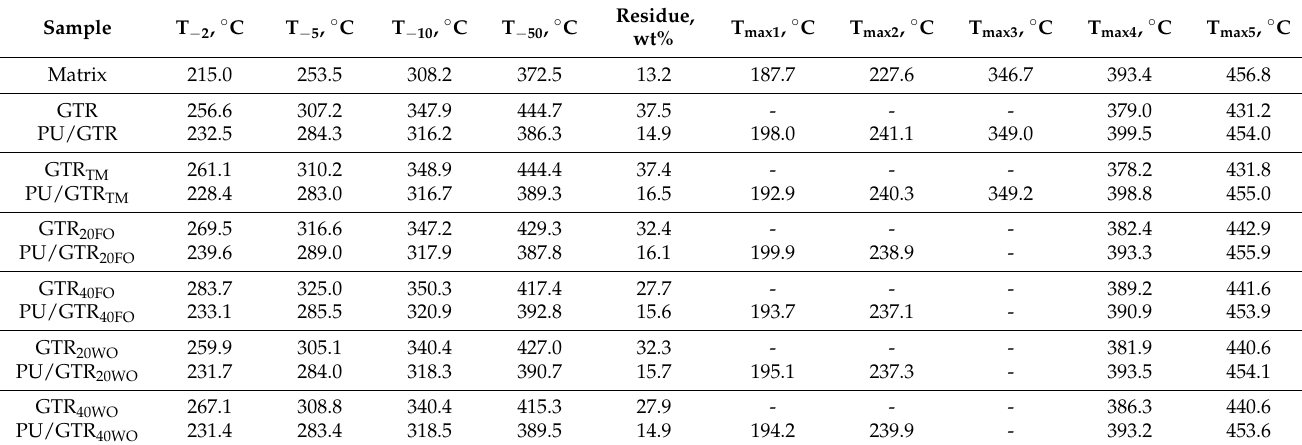
Table 4. The results of the thermogravimetric analysis for prepared polyurethane foams and applied ground tire rubbers.